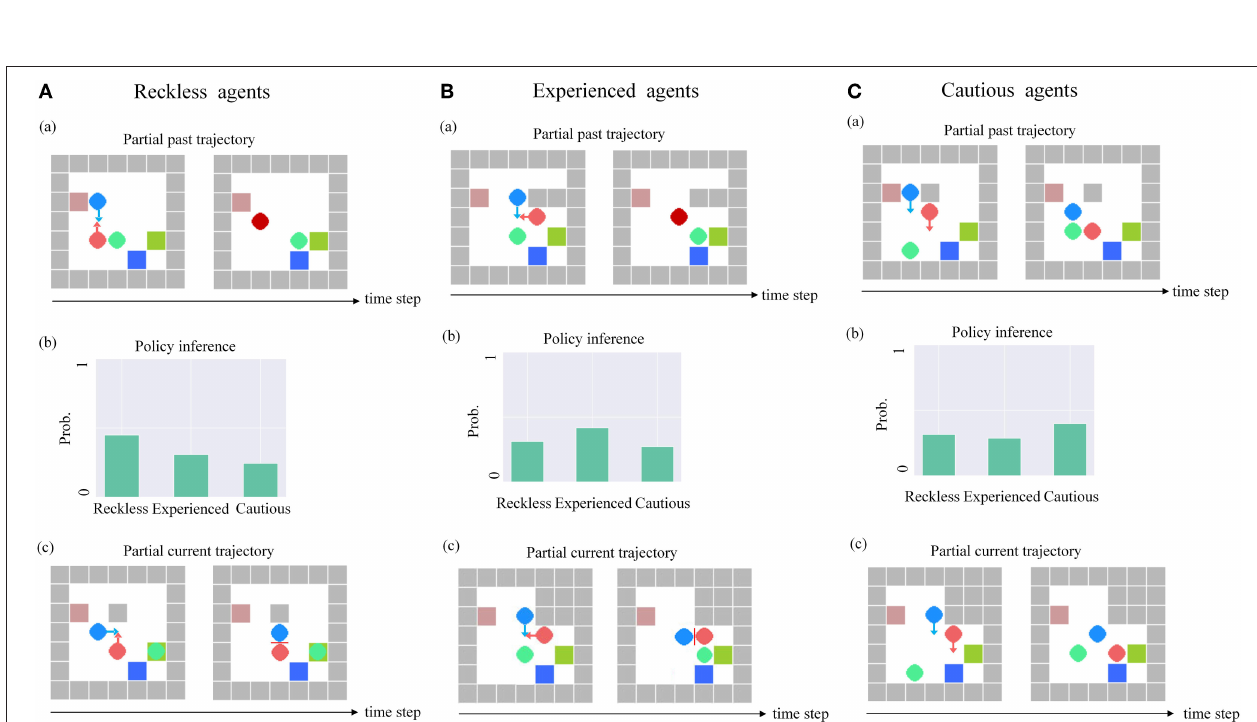
FIGURE 6 | (A) Histograms of three kinds of pedestrian 2’s performance scores. The horizontal axis represents performance scores, and the vertical axis represents the number of occurrences of scores. (B) Histograms of three kinds of pedestrian 2’s risks assessment. The horizontal axis represents the two states of risk and safety, and the vertical axis represents the number of occurrences of the different states.